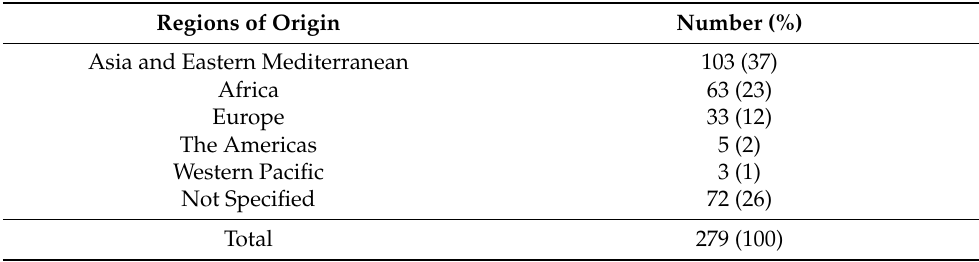
Table 2. Regions of origins of refugees and asylum seekers, reported in records (n = 279) .